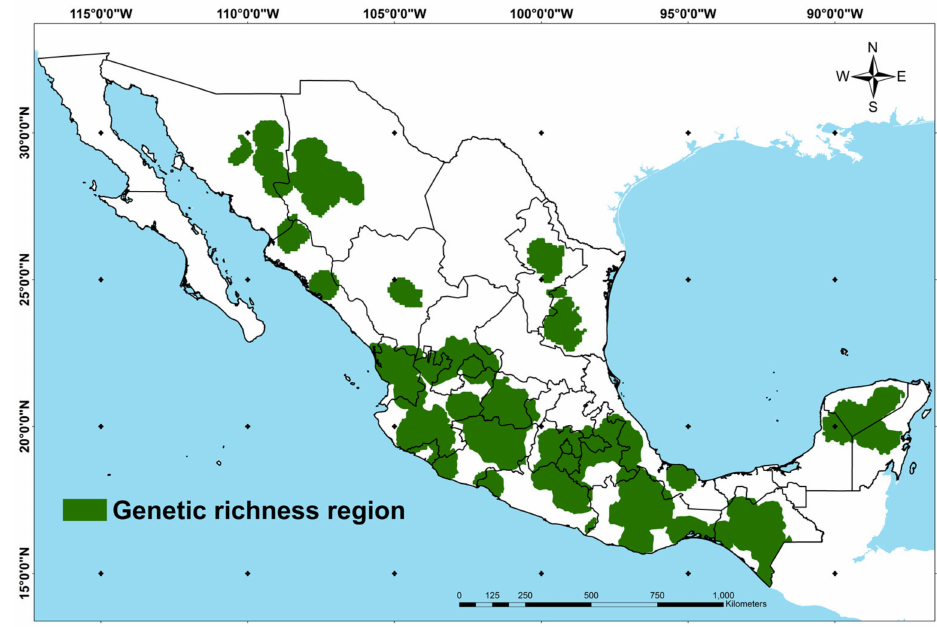
Figure 2. Genetic richness region for the 64 maize races cultivated in